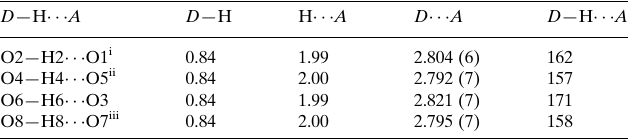
Hydrogen-bond geometry (A˚ , (cid:2)